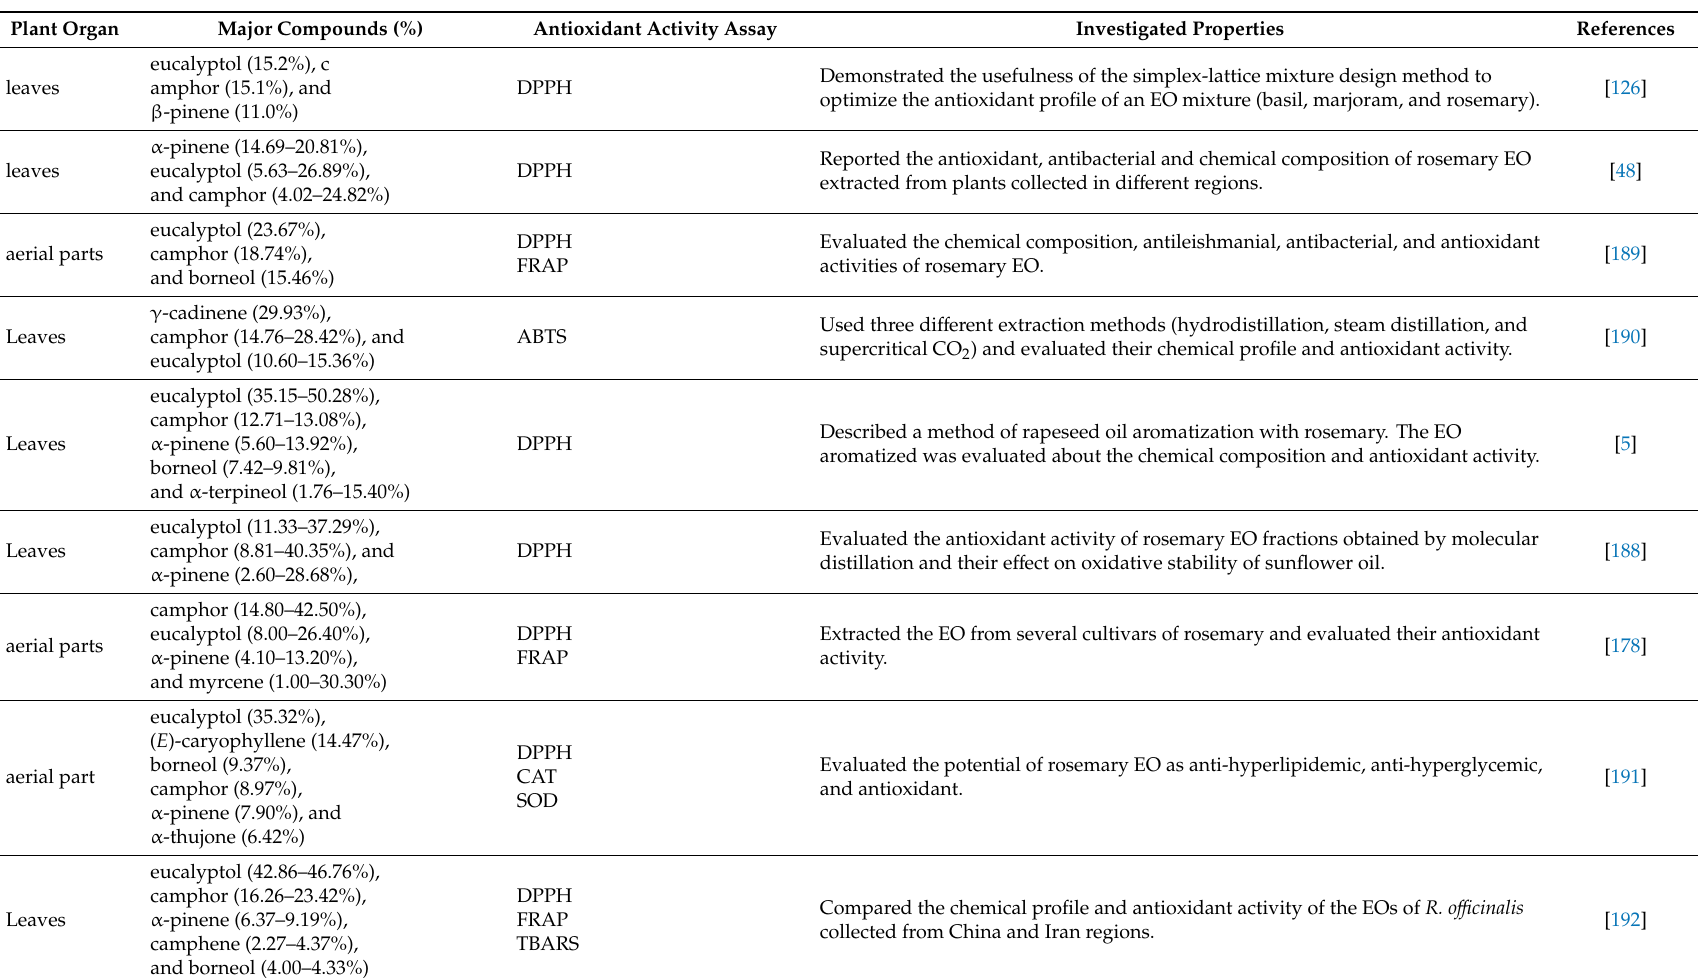
Table 6. Major natural compounds, methodologies applied to determine the antioxidant activity, and the investigated applications of Rosmarinus o ffi cinalis (Lamiaceae)